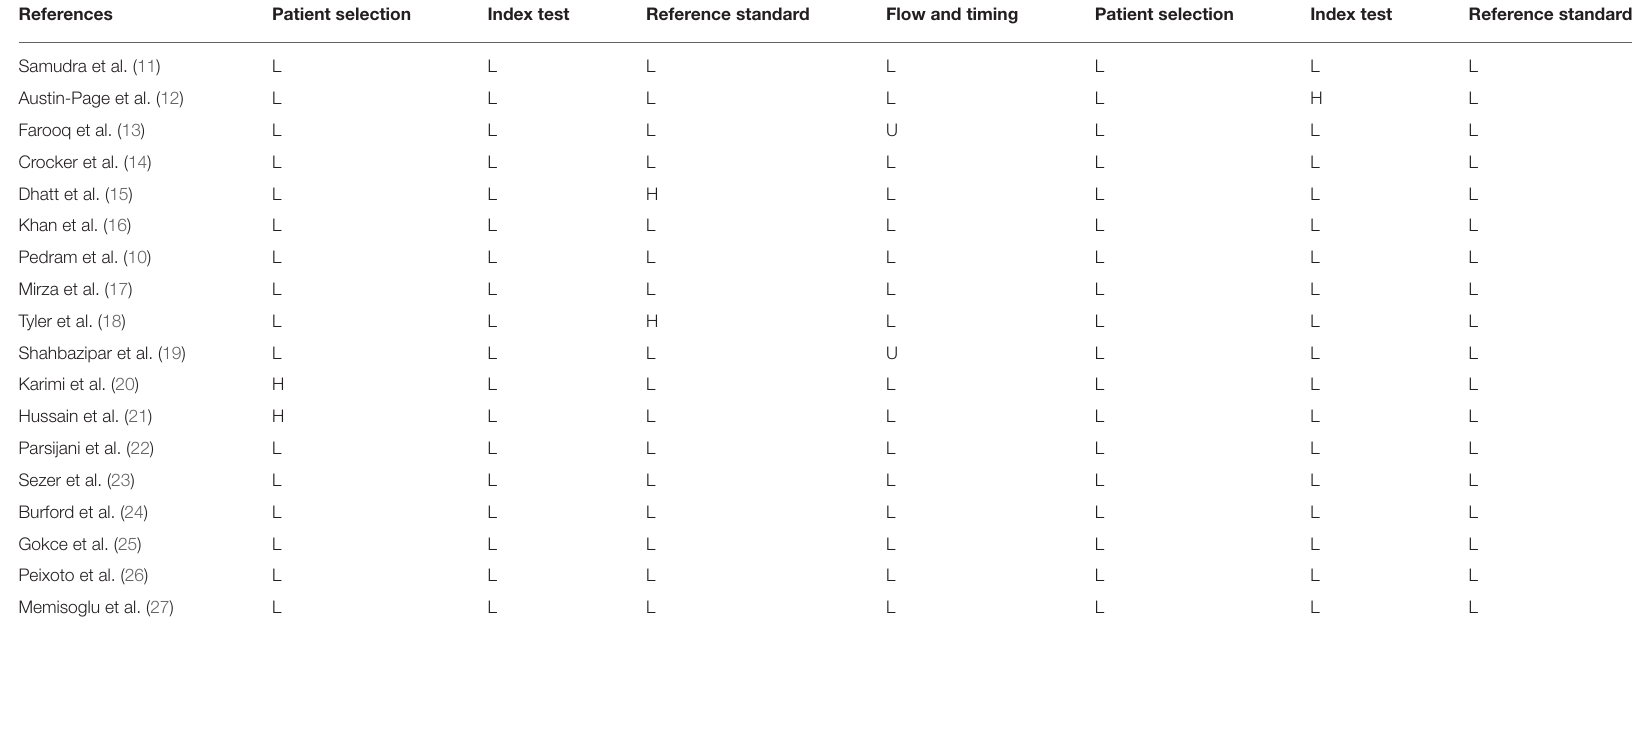
TABLE 2 | Risk of bias